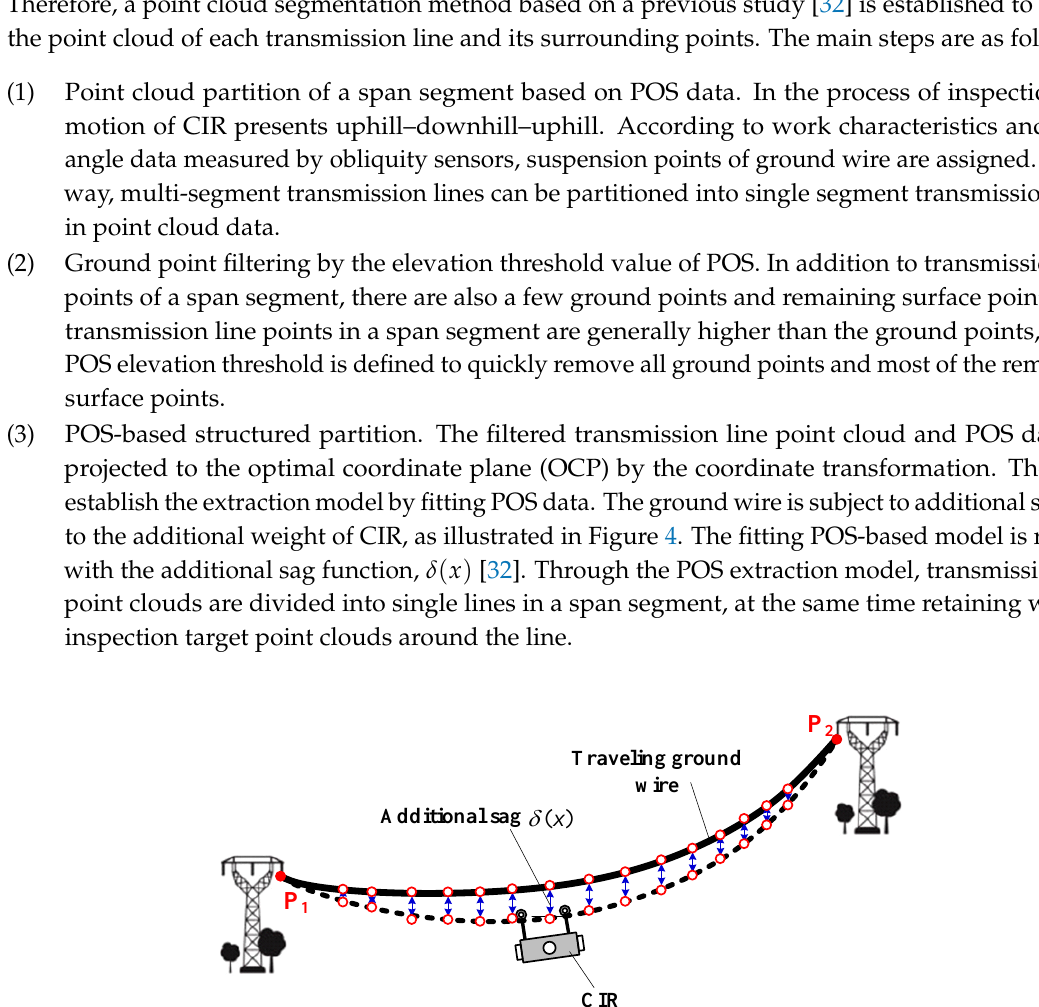
Figure 5. The classification of inspection targets on a transmission line. Through analysis, inspection targets are attached to a transmission line or its surroundings. The different types of inspection targets have their own characteristics, as illustrated in Table 2.